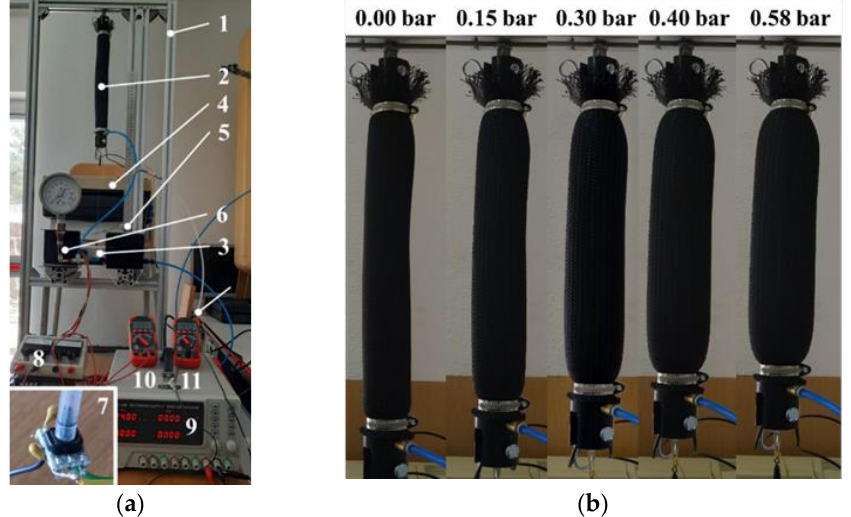
Figure 9. Experimental validation of the proposed MKM: ( a ) the employed testbed; ( b ) Photographs of the MKM configurations for five different internal pressure values.